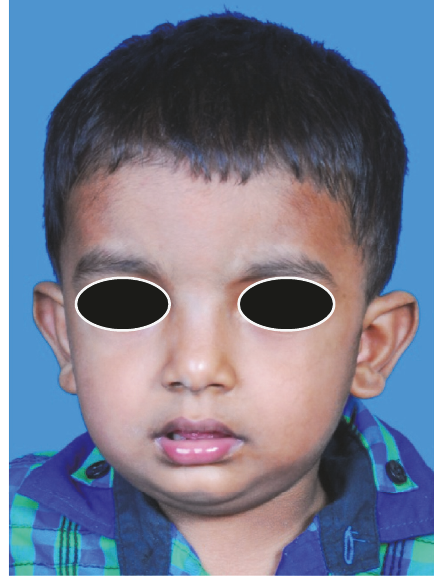
Figure 5: Postoperative photograph.